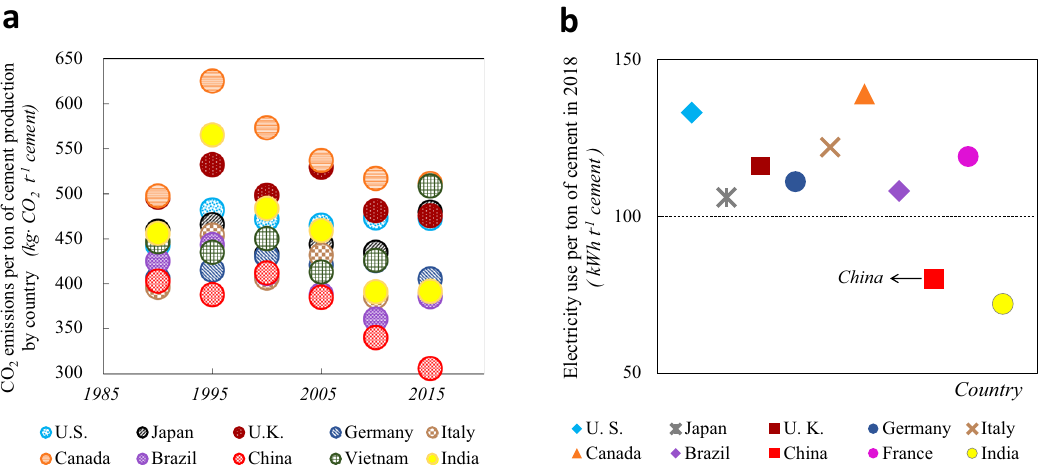
Fig. 4 CO 2 emissions and electricity use per ton of cement manufacturing globally. a compares the average CO 2 emissions per ton of cement produced by country from 1990 to 2015. Here, the total CO 2 emissions of cement production in each country 5 are divided by the country ’ s total cement production 47 . b illustrates the electricity use per ton of cement produced in 2018. The data are collected from the International Energy Agency 79 .